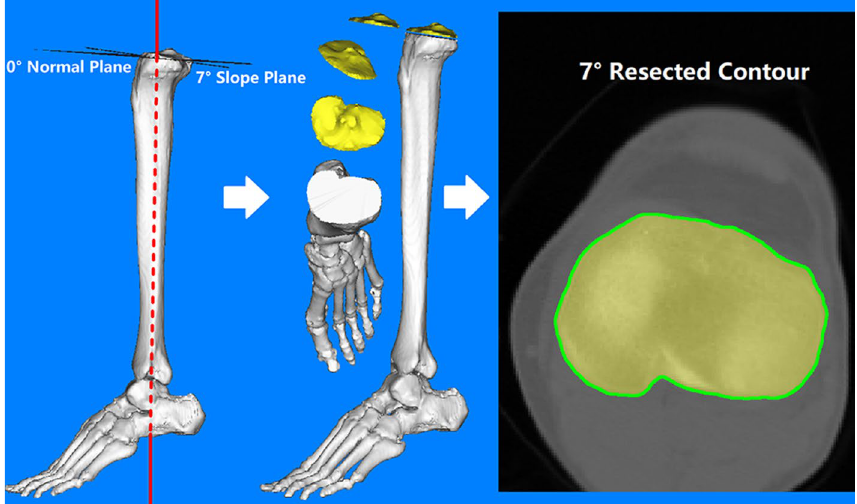
Figure 1. A simplified flow diagram of the virtual osteotomy and the resected contour extraction from a three- dimensional bone model. Red line: the longitudinal axis of the tibial shaft which was used to calculate the 0° normal